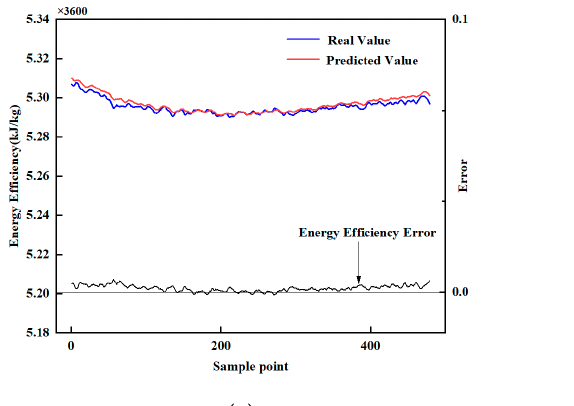
ficiency of atmospheric two-line products. ( b ) Prediction of energy efficiency of vacuum two-line